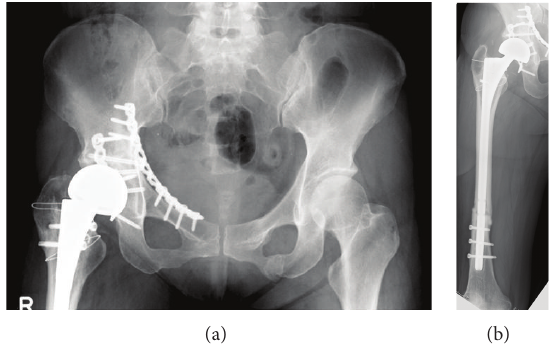
Figure 6: Anteroposterior radiographs of the pelvis (a) and femur (b) 1 year after